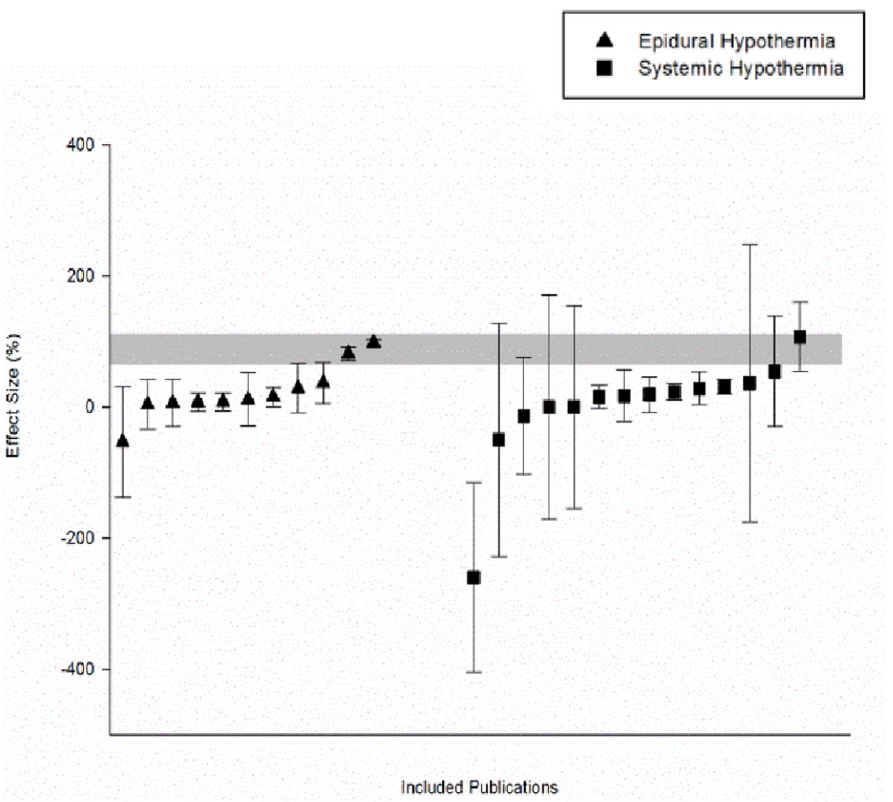
Figure 2. Effect sizes of included publications. Scatter plot demonstrating the distribution of effect sizes (% improvement in neurobiological score) within the included publications (n=16). Individual experiments that employed a regional cooling approach (n=11) vs. a systemic cooling approach (n=14) have been identified and plotted as separate subgroups. The shaded gray bar represents the 95% confidence limits of the global estimate. The vertical error bars represent the 95% confidence intervals for the individual estimates. The width of each bar reflects the log of the number of animals contributing to that comparison. doi:10.1371/journal.pone.0071317.g002 used and the remaining 13 experiments used five different fentanyl). We did not observe a significant effect of these model anaesthetic strategies during surgical procedures (halothane, specific parameters on outcome. We also investigated therapeutic isoflurane, sodium pentothal, ketamine/xylazine, and fluanison/ specific parameters. The dose of hypothermia ranged from 28 u C